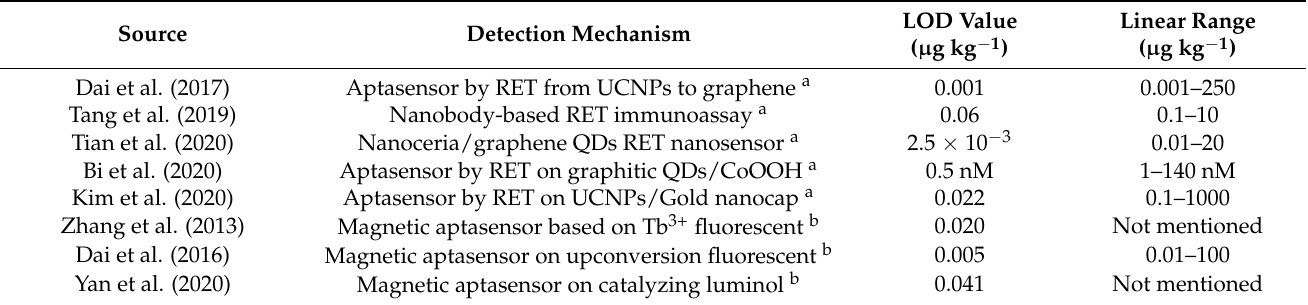
Table 3. The recent homogeneous bioassays for rapid screening of Ochratoxin